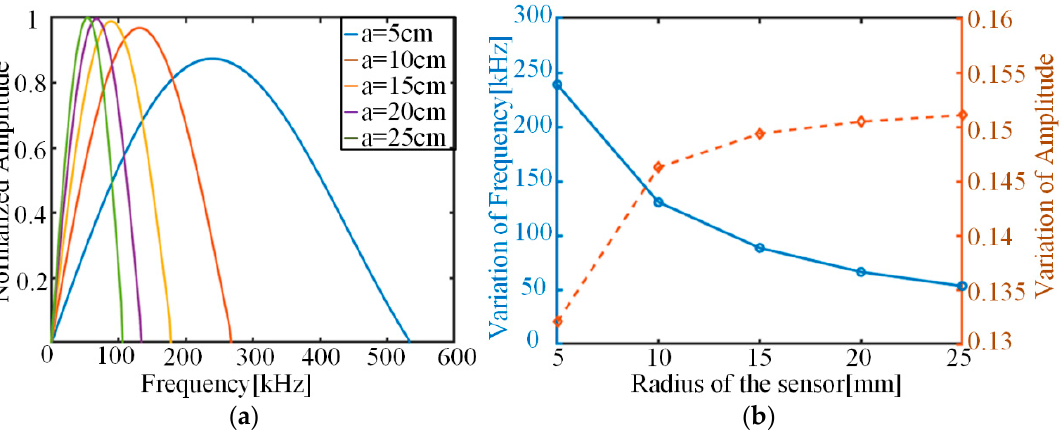
Figure 12. Variation in predicted AE results for different sensor radiuses: ( a ) variation in model-